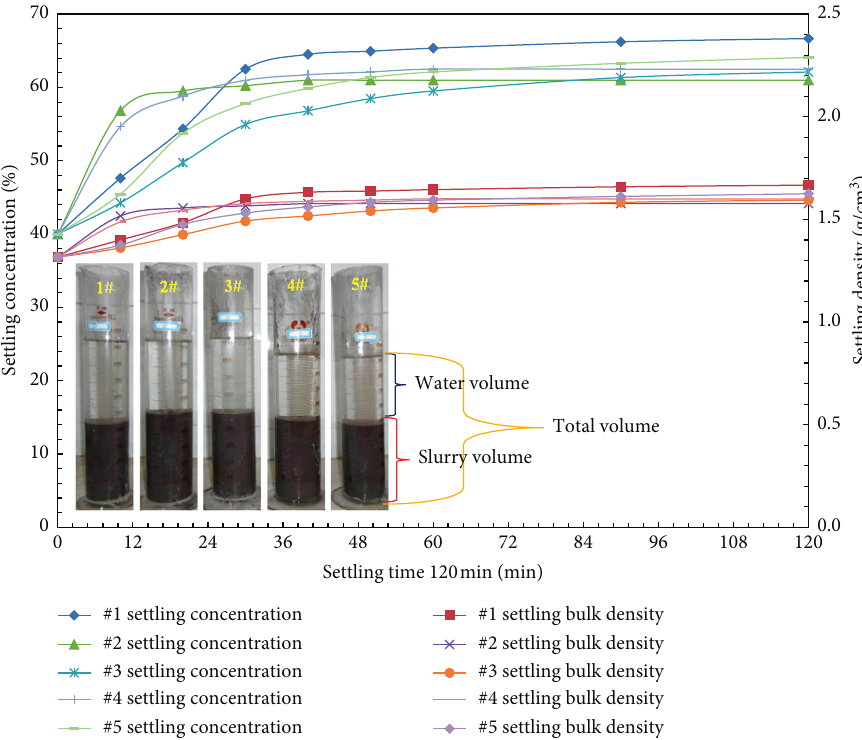
Figure 16: Curves of settling concentration and bulk density